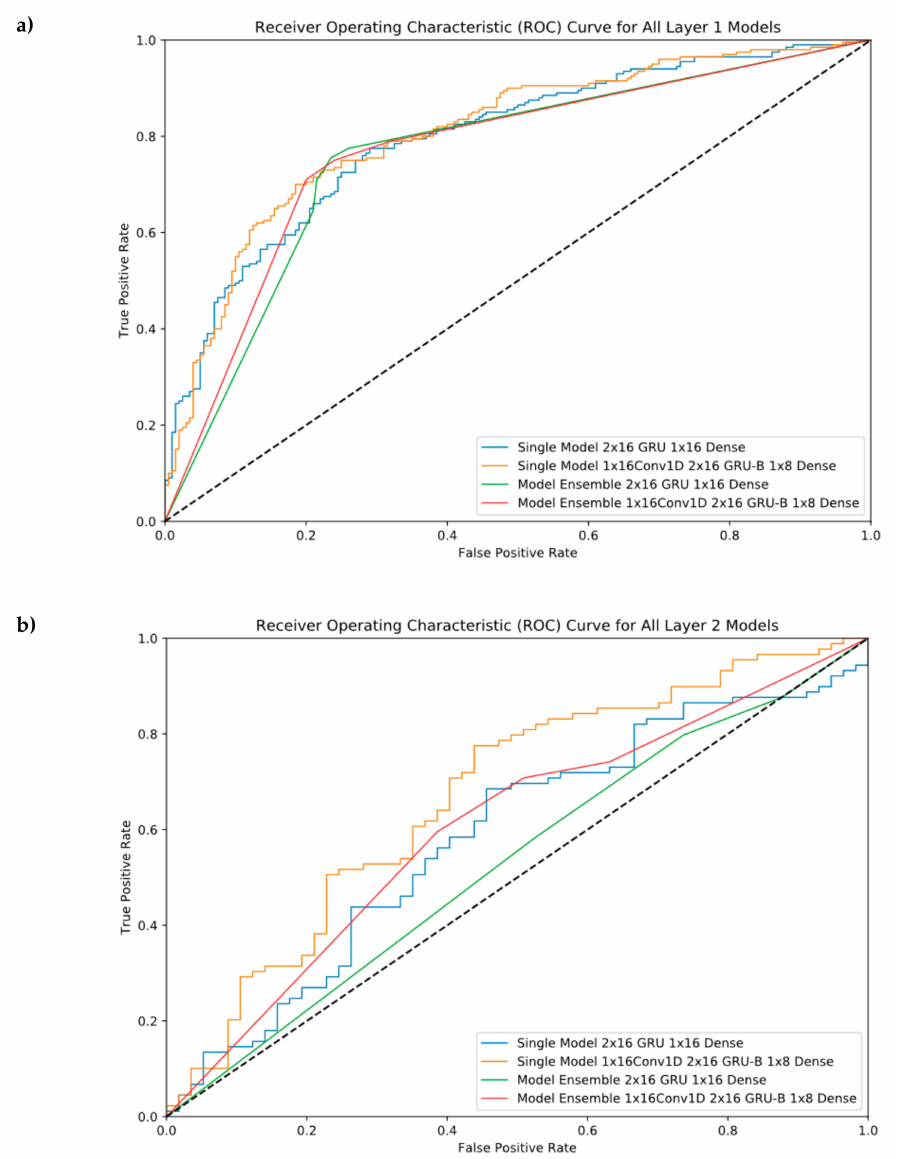
Figure 4. Receiver Operating Characteristic (ROC) Curve for all single and ensemble models. ( a ) Layer 1 classification, ( b ) Layer 2